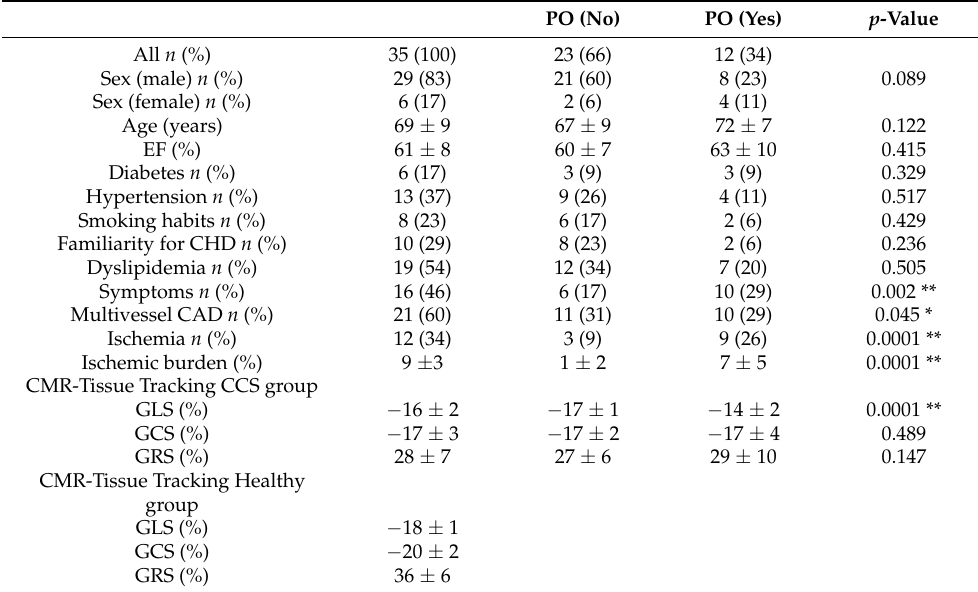
PO: primary outcomes; EF: ejection fraction; CHD: coronary heart disease; CAD: coronary artery disease; CMR: cardiac magnetic resonance; GLS: global longitudinal strain; GCS: global circumferential strain; GRS: